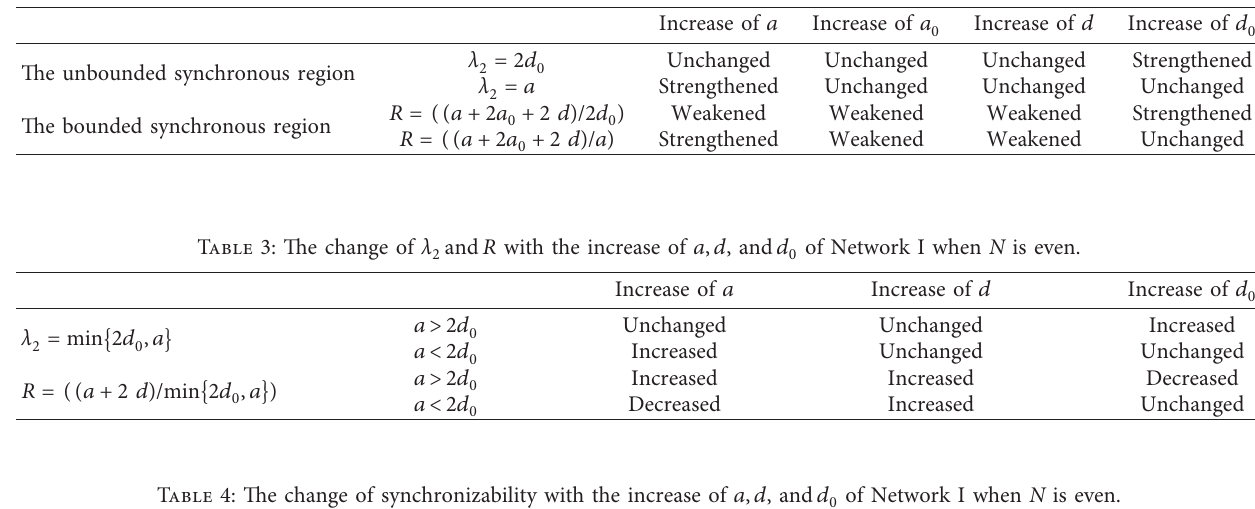
Table 2: The change of synchronizability with the increase of a,a